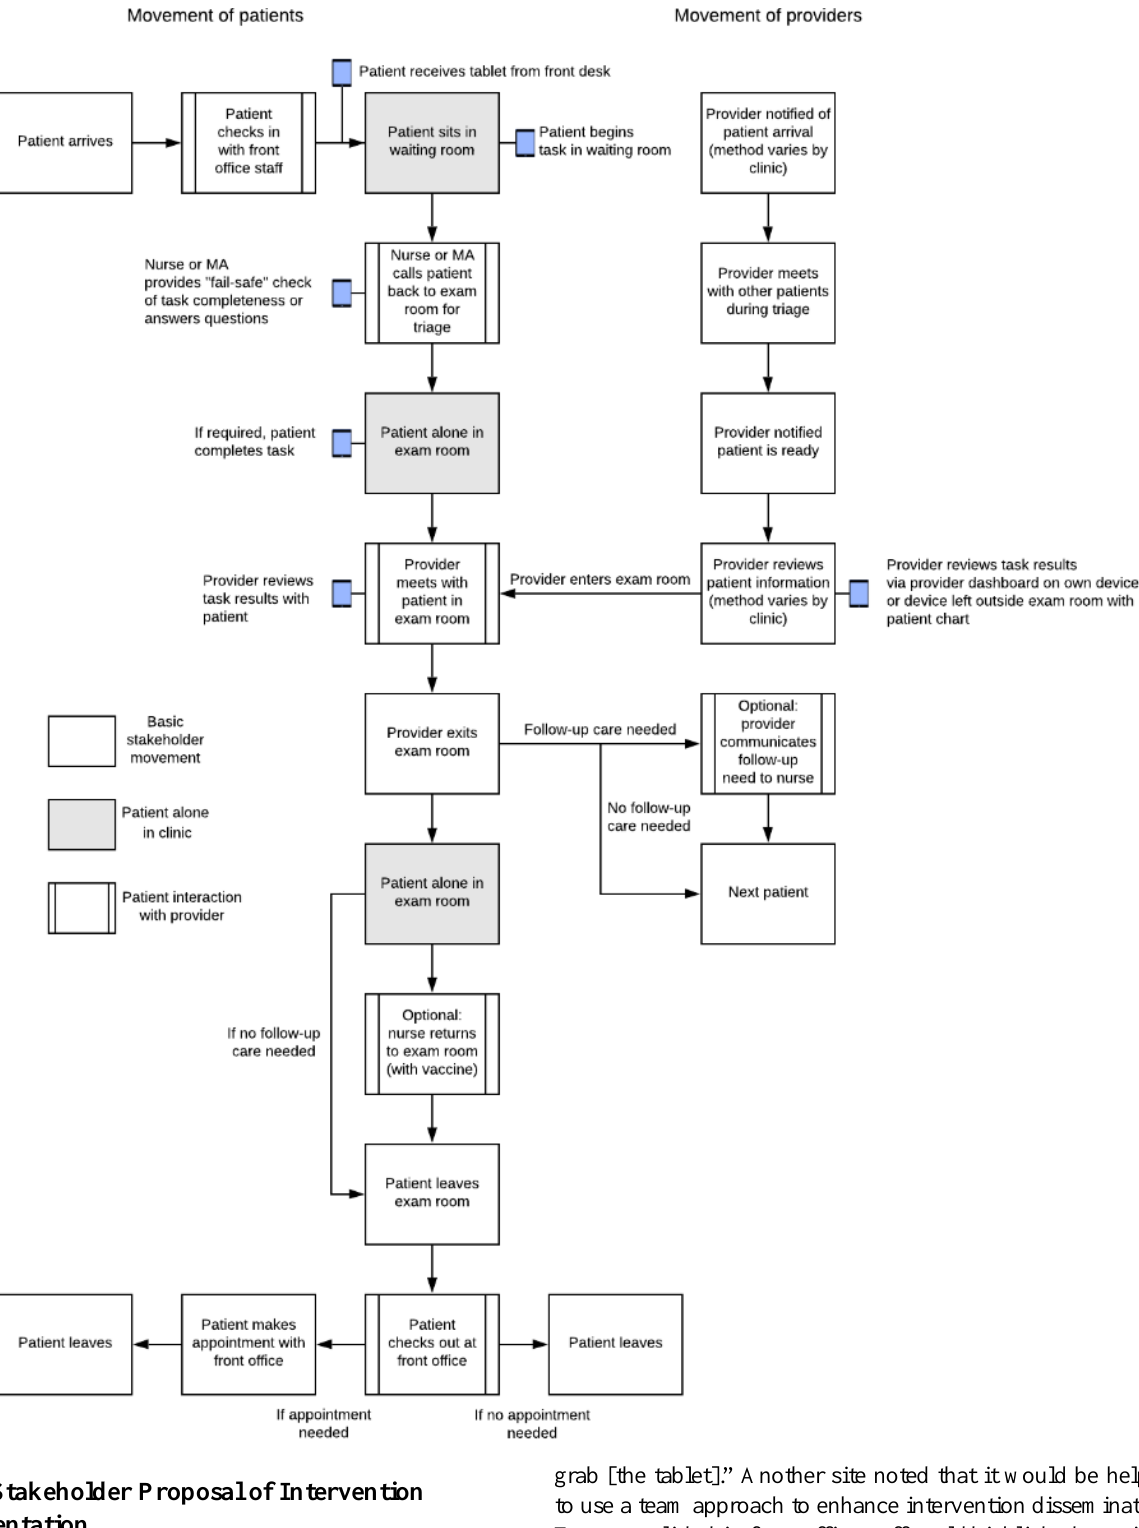
Figure 1. Example clinical workflow diagram of patient visits (those aged 11-12 years) with the proposed intervention tablet placement. MA: medical